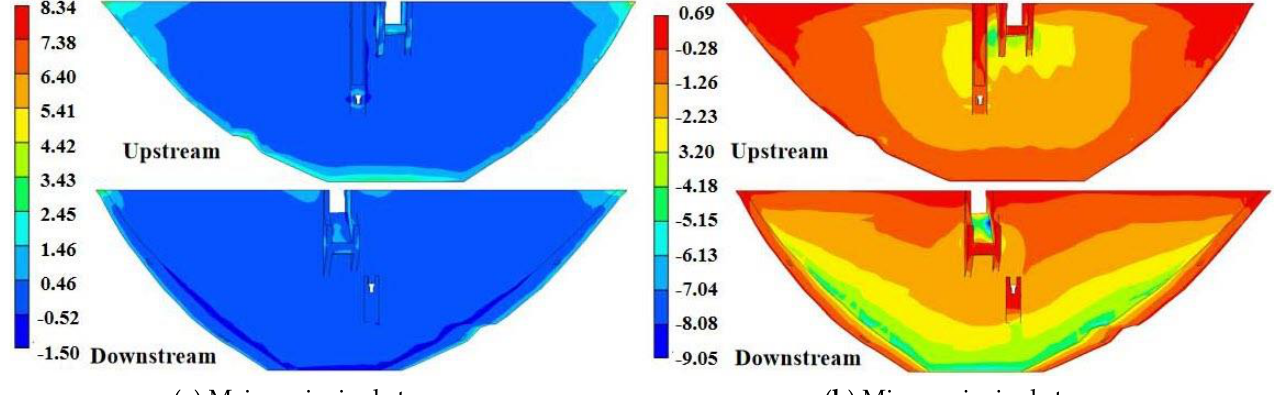
Figure 12. Contour map of dam stress under measured uplift pressure (Unit: MPa).